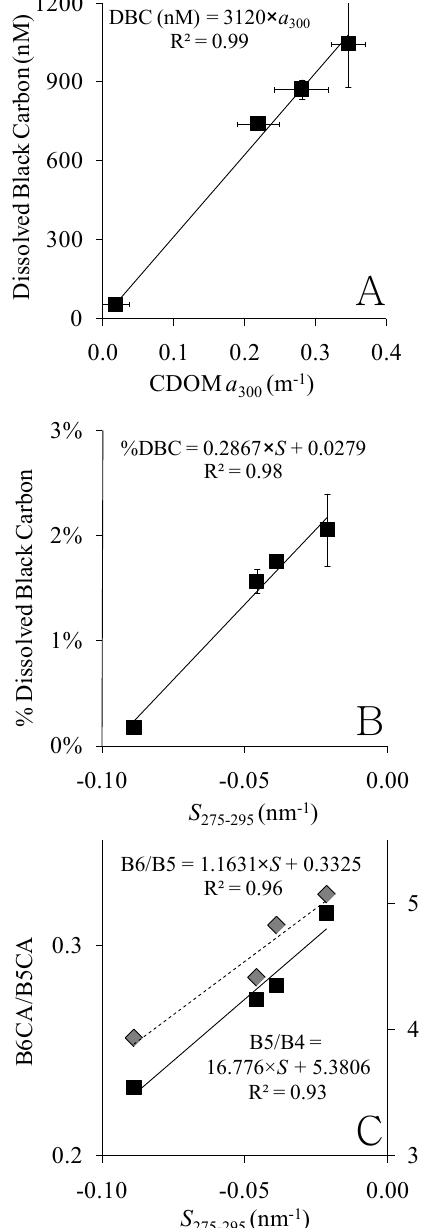
Fig. 2. Correlations between the optical properties of coloured dis- solved organic matter (CDOM) and dissolved black carbon (DBC) quantity and quality over the course of a 28 day irradiation. Panel A: DBC concentration versus the CDOM Naperian absorption co- efficient at 300nm (CDOM a 300 ) . Panel B: DBC as a percentage of total dissolved organic carbon versus the CDOM spectral slope be- tween 275 and 295nm ( S 275 − 295 ) . Panel C: ratios of DBC derived benzenecarboxylic acids versus S 275 − 295 . Black squares and solid regression line are for B6CA/B5CA. Grey diamonds and broken re- gression line are for